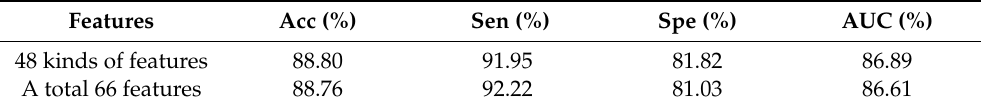
Table 8. Two best performances in hill-climbing iterations with 48 and 66 features.